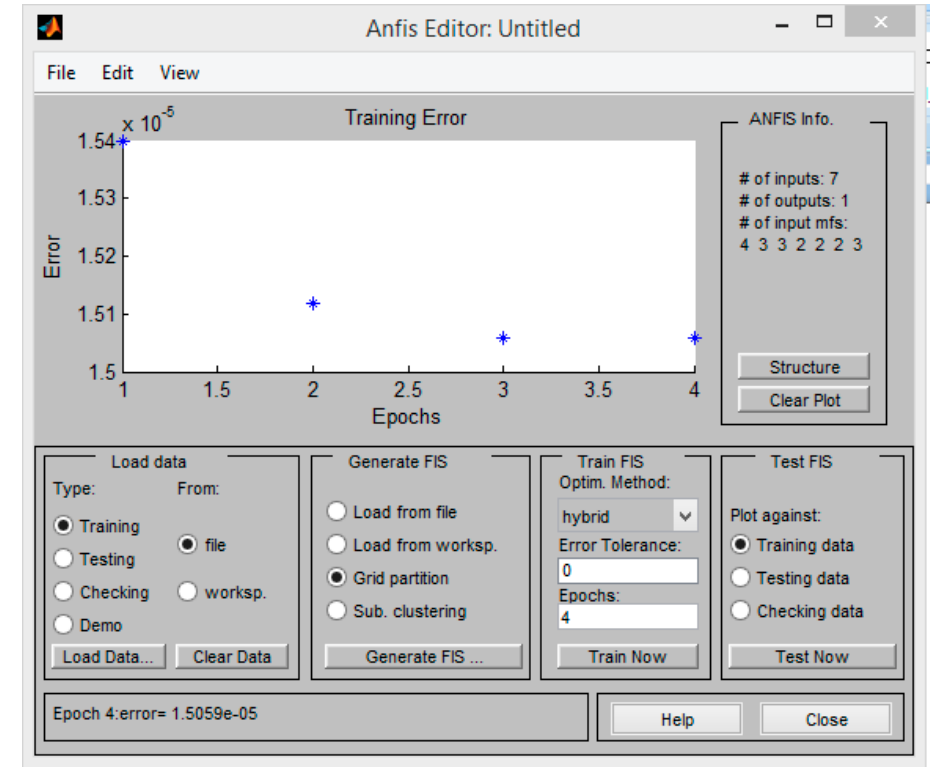
Figure 14. Training error at 4 epochs.